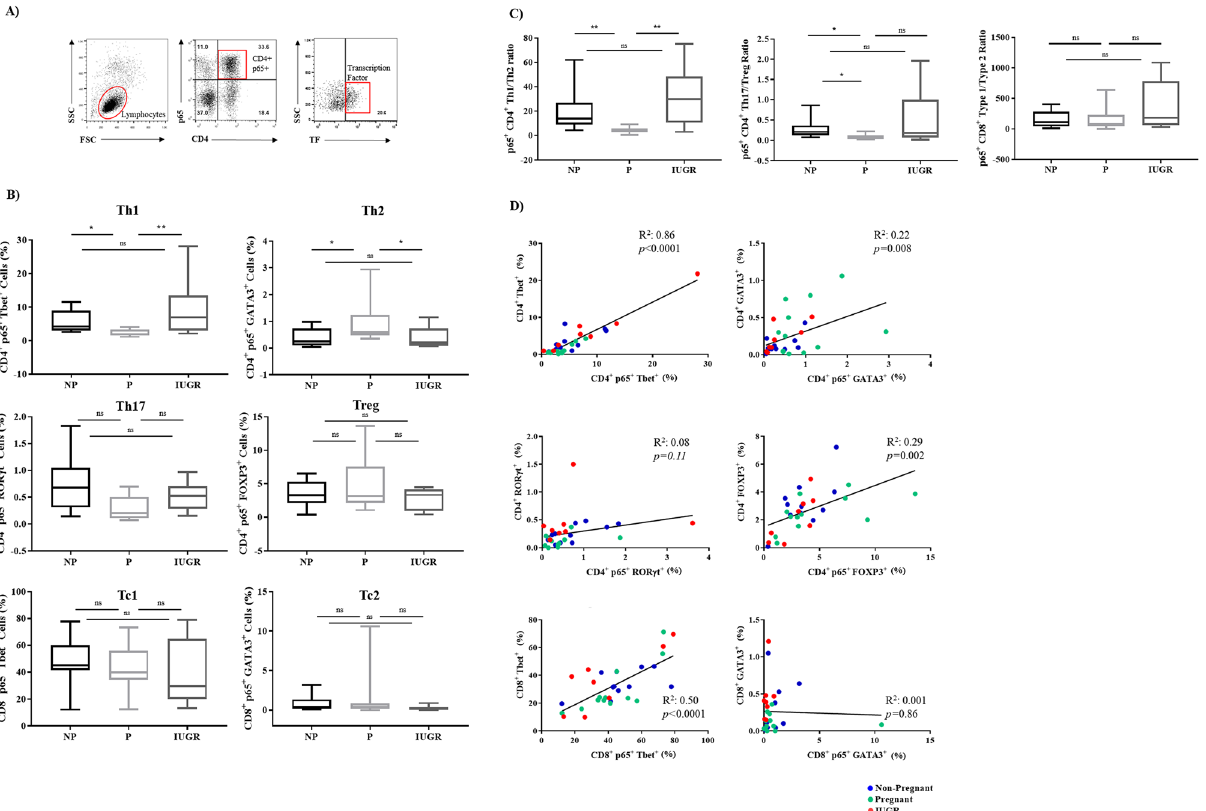
Figure 4. Expression of p65 in T-cell subsets is altered during normal pregnancy compared to IUGR. ( A ) Gating strategy for flow cytometry analysis of cells expressing p65 in CD4/CD8 + T-cells. ( B ) Percentage of T-cell subsets expressing p65 was determined by flow cytometry in Th1, Th2, Th17, Treg cells, Tc1, and Tc2 from NP (n = 11), P (n = 12) and IUGR (n = 8). Box and whisker plots indicate median and IQR of cells expressing p65. * p < 0.05, ** p < 0.01 , ns = non- significant, determined by Kruskal–Wallis with Dunn’s multiple comparisons test due to small sample size. ( C ) Percentage of cells expressing p65 was compared between pro-inflammatory and anti-inflammatory CD4 + T-helper cell subsets as a ratio of Th1 and Th2, or Th17 and Treg, or CD8 + Tc1 and Tc2, from non-pregnant women (NP) (n = 11), normal pregnant women (P) (n = 12) and pregnant women complicated with IUGR (n = 8). Box and whisker plots indicate median and IQR of ratios. * p < 0.05, ** p < 0.01, ns = non-significant, according to the Kruskal–Wallis. ( D ) Linear regression analysis was used to assess the relationship between regulation of transcription factors and p65 expression in CD4 + and CD8 + T-cells. p65 expression was correlated with CD4 + Tbet (Th1), GATA3 (Th2), RORγt (Th17), FOXP3 (Treg), CD8 + Tbet (Tc1), or CD8 + GATA3 (Tc2). Non-Pregnant (n = 11; blue); Pregnant (n = 12; green); IUGR (n = 8; red).